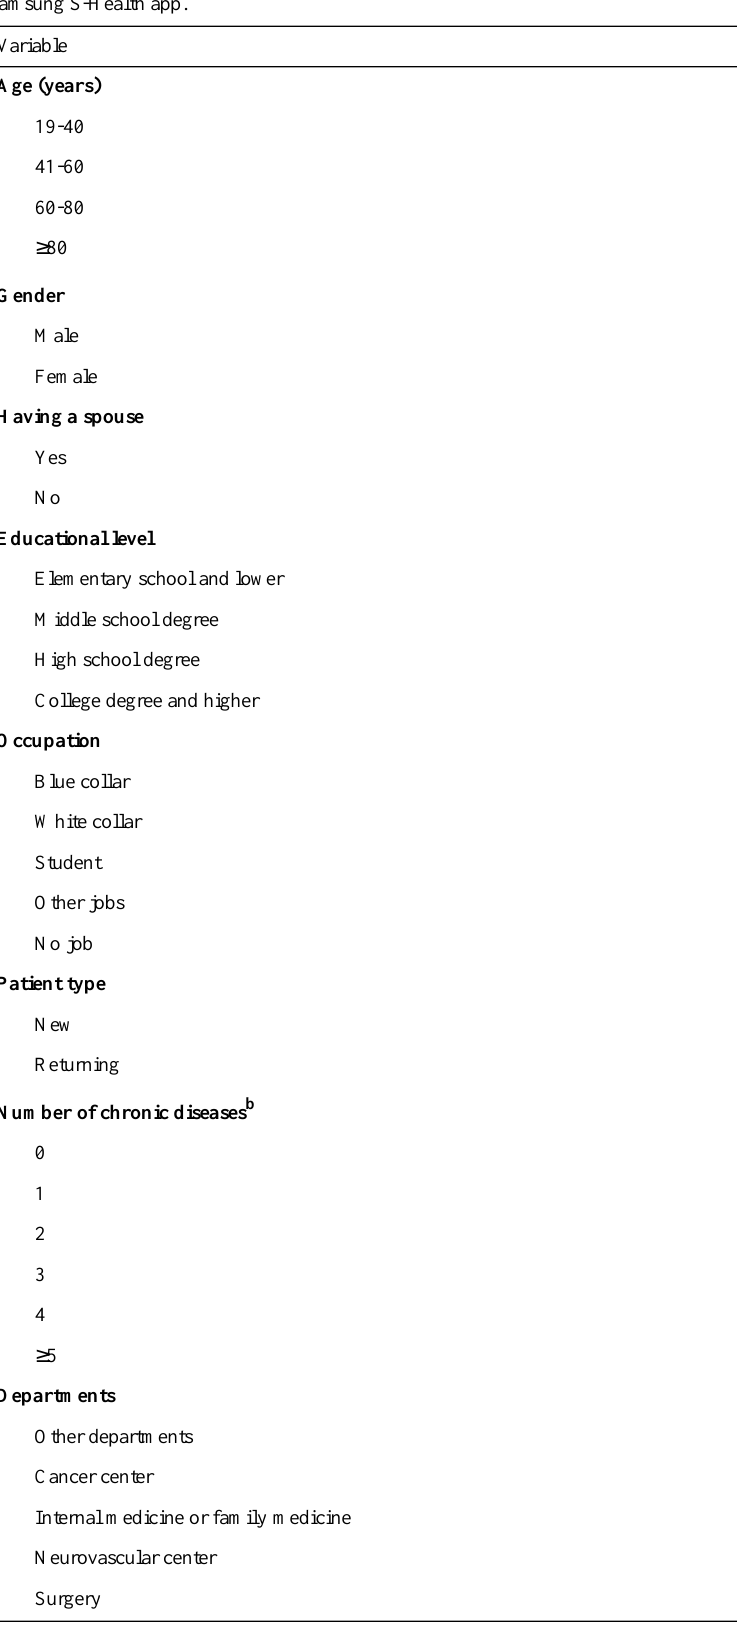
Table 7. Multivariable analysis of the factors associated with the use of the Consolidated Clinical Document Architecture integration function in the Samsung S-Health